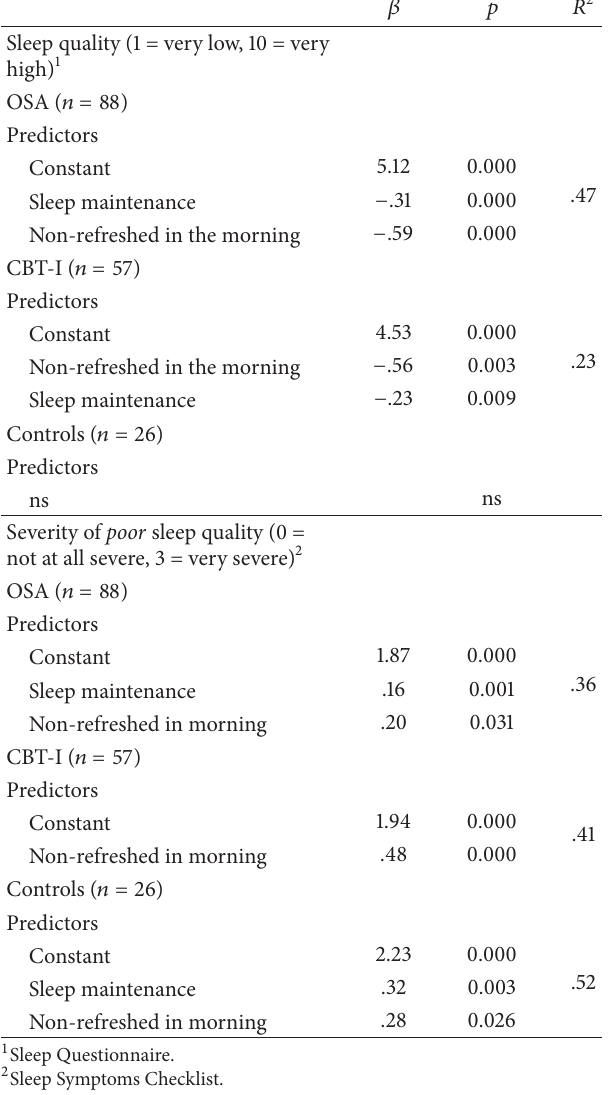
Table 4: Predicting sleep quality: study-wise linear regression. 𝛽 𝑝 𝑅